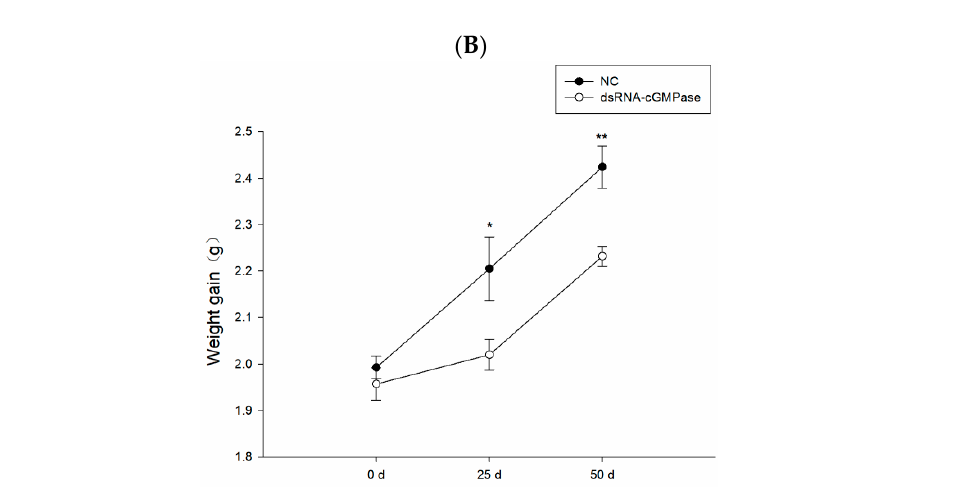
Figure 9. S. constricta growth after the long-term injection of dsRNA- cGMPase . Shell length ( A ) and weight gain ( B ) at 0, 25, and 50 days after injection. A single asterisk means there is a signifificant difference (* p < 0.05), and double asterisks mean a highly significant difference (** p < 0.01).